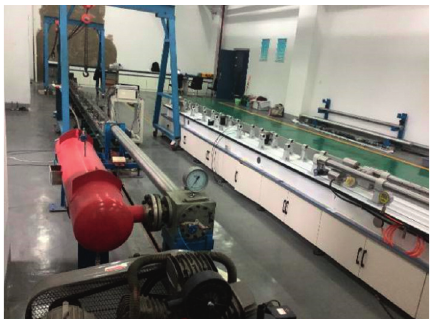
Figure 2: Laboratory SHPB test